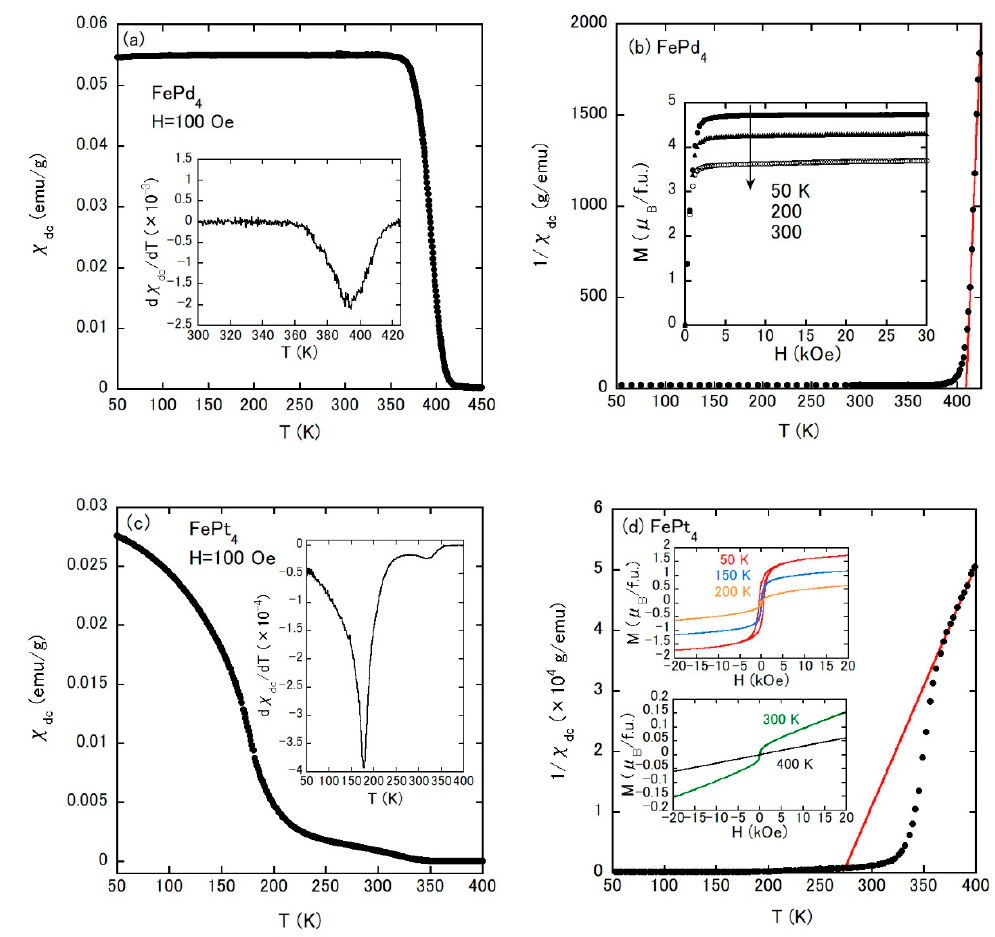
Figure 4. ( a ) Temperature dependence of χ dc under an external field of 100 Oe for FePd 4 . The inset is the temperature derivative of χ dc . ( b ) Temperature dependence of 1/ χ dc of FePd 4 . The inset shows the isothermal magnetization curves of FePd 4 at 50, 200, and 300 K. ( c ) Temperature dependence of χ dc under an external field of 100 Oe for FePt 4 . The inset is the temperature derivative of χ dc . ( d ) Temperature dependence of 1/ χ dc of FePt 4 . The insets are the isothermal magnetization curves of FePt 4 at 50, 150, 200, 300, and 400 K.